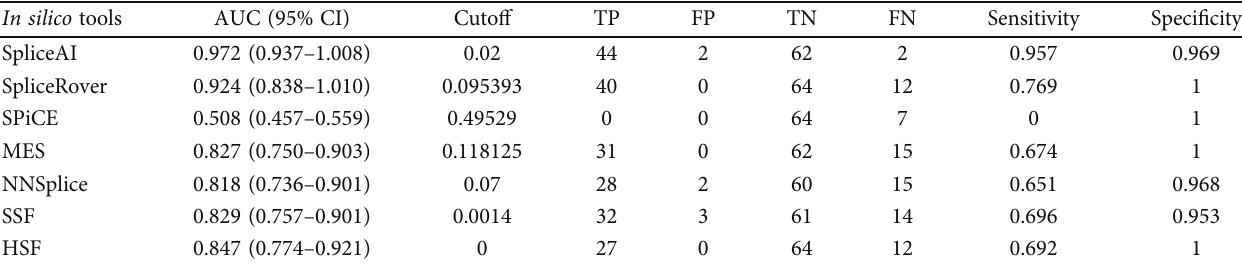
Table 2: Summary of evaluation measures for 7 in silico tools only for de novo or cryptic splice sites. In silico